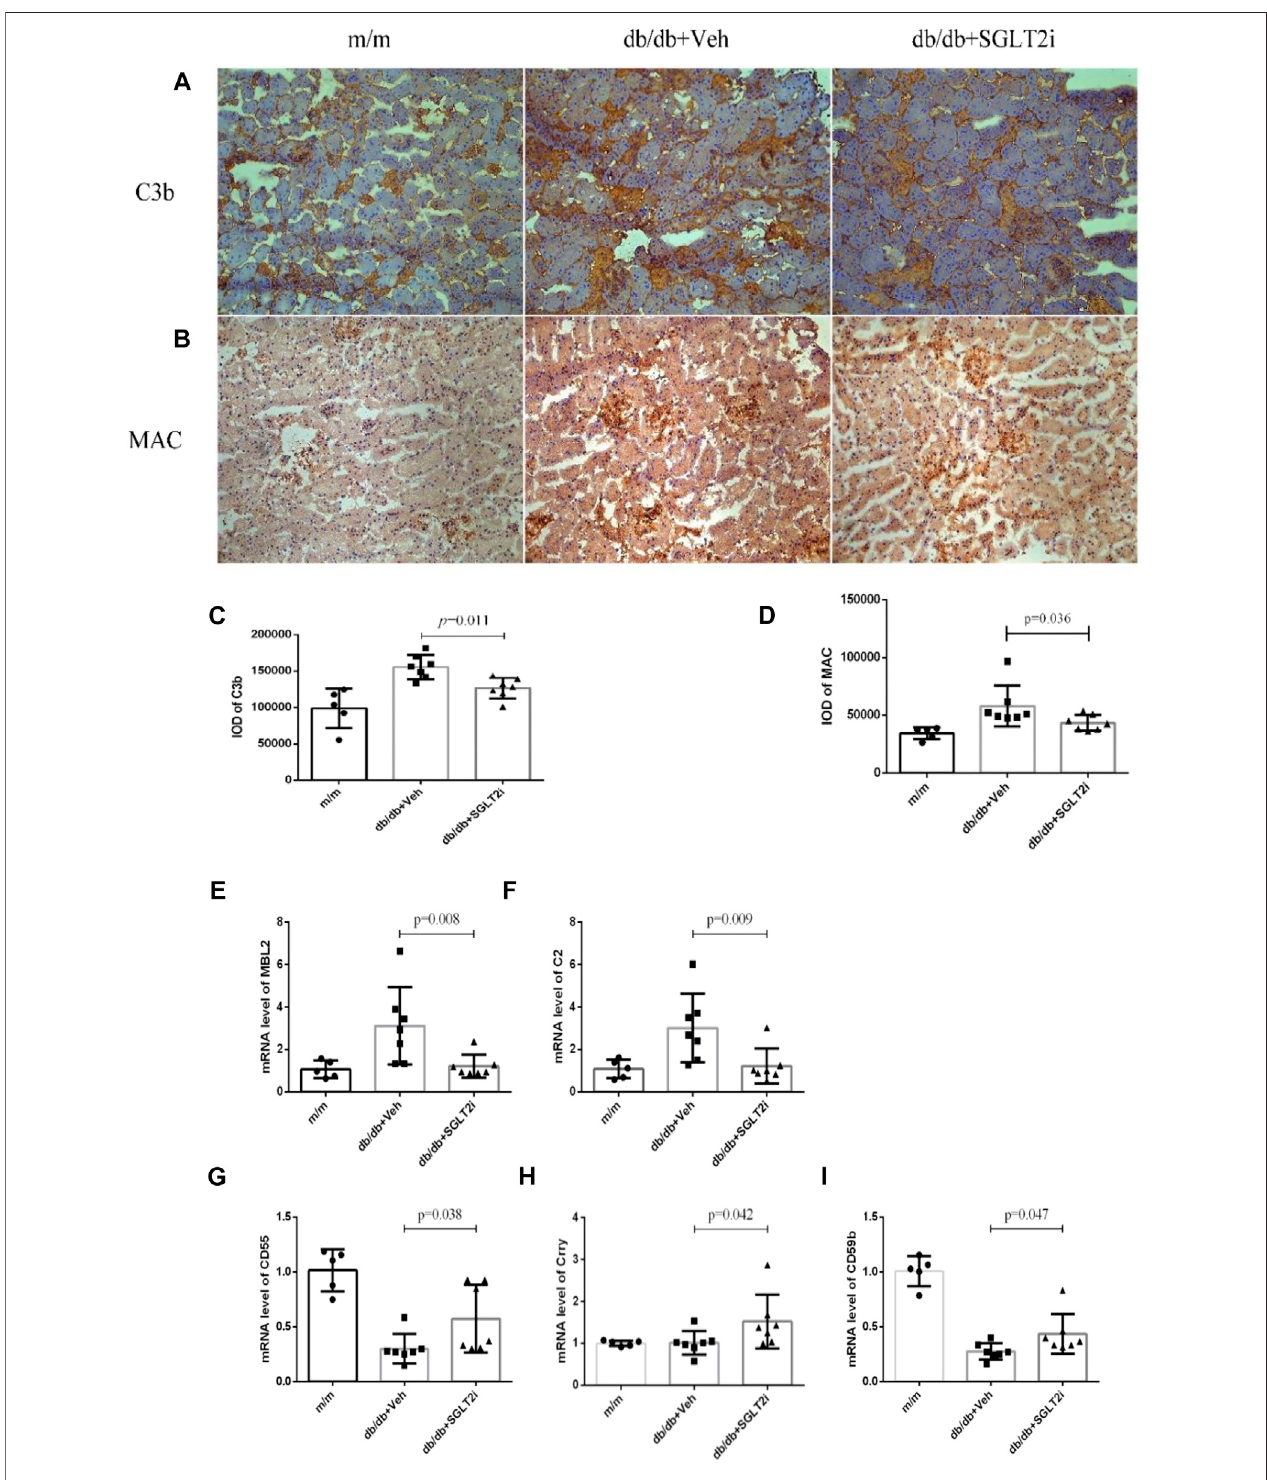
FIGURE 2 | Dapagli fl ozin suppressed kidney complement over-activating in db/db mice and upregulated Crry expression. (A) Representative immunohistochemical staining of C3b from m/m mice ( n (cid:2) 5), vehicle-treated db/db mice ( n (cid:2) 7) and SGLT2i-treated db/db mice ( n (cid:2) 7), Bar (cid:2) 100 μ m. (B) Representative immunohistochemical staining of MAC. (C) Integral optical density of C3b deposition. (D) Integral optical density of MAC deposition. Real-time qPCR analysis of mRNA level change (E) MBL, (F) C2, (G) CD55, (H) Crry, (I) CD59. MBL, mannan binding lectin; C2, complement 2; MAC, membrane attack complex.